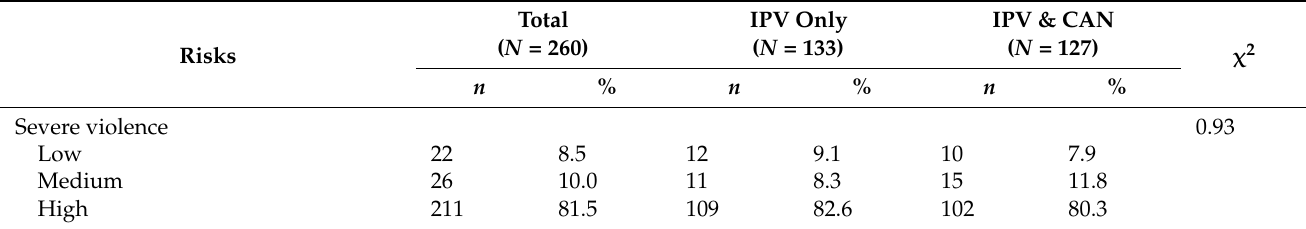
Table 6. Levels of Risks Associated with IPV and